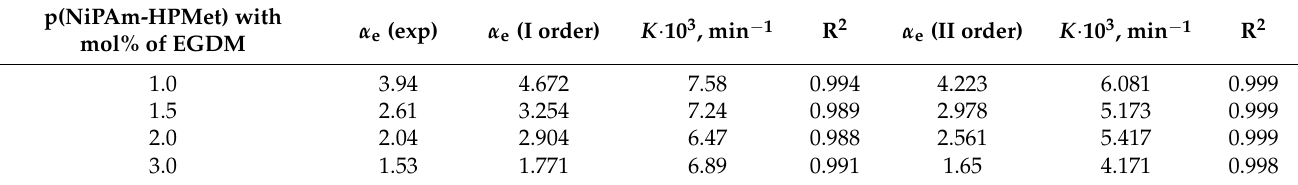
Table 6. Values of the experimentally obtained and calculated normalized equilibrium swelling degree and kinetic parameters of the first and second order reaction at 40 ◦